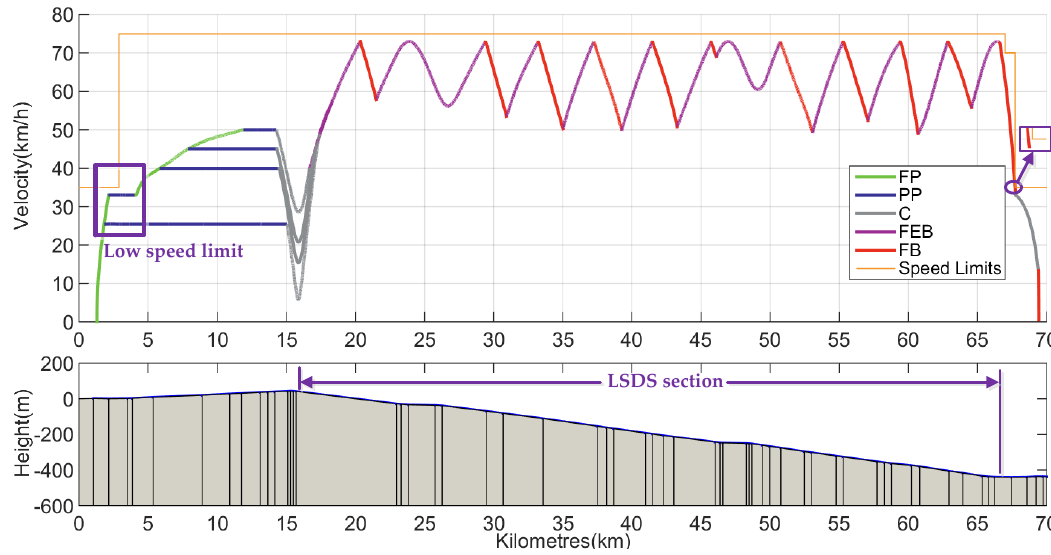
Figure 14. Optimal velocity trajectories and track height.